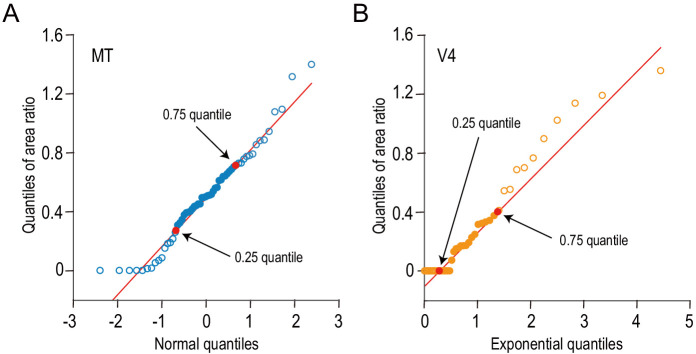
The distributions of the area ratios for MT and V4 are compared against normal and exponential distributions, respectively.We examined the shapes of area-ratio distributions using quantile–quantile plots. (A) The quantiles of area ratios for MT are plotted against the theoretical quantiles expected from the standard normal distribution. (B) Likewise, the quantiles of V4 data are plotted against the theoretical quantiles expected from an exponential distribution (mean = 1). Red lines are drawn through the 0.25 and 0.75 quantiles. The data between these two points are well aligned on the red lines, meaning that the area-ratio distributions from MT and V4 follow the normal and exponential distributions, respectively, within the middle 50% of the data range.